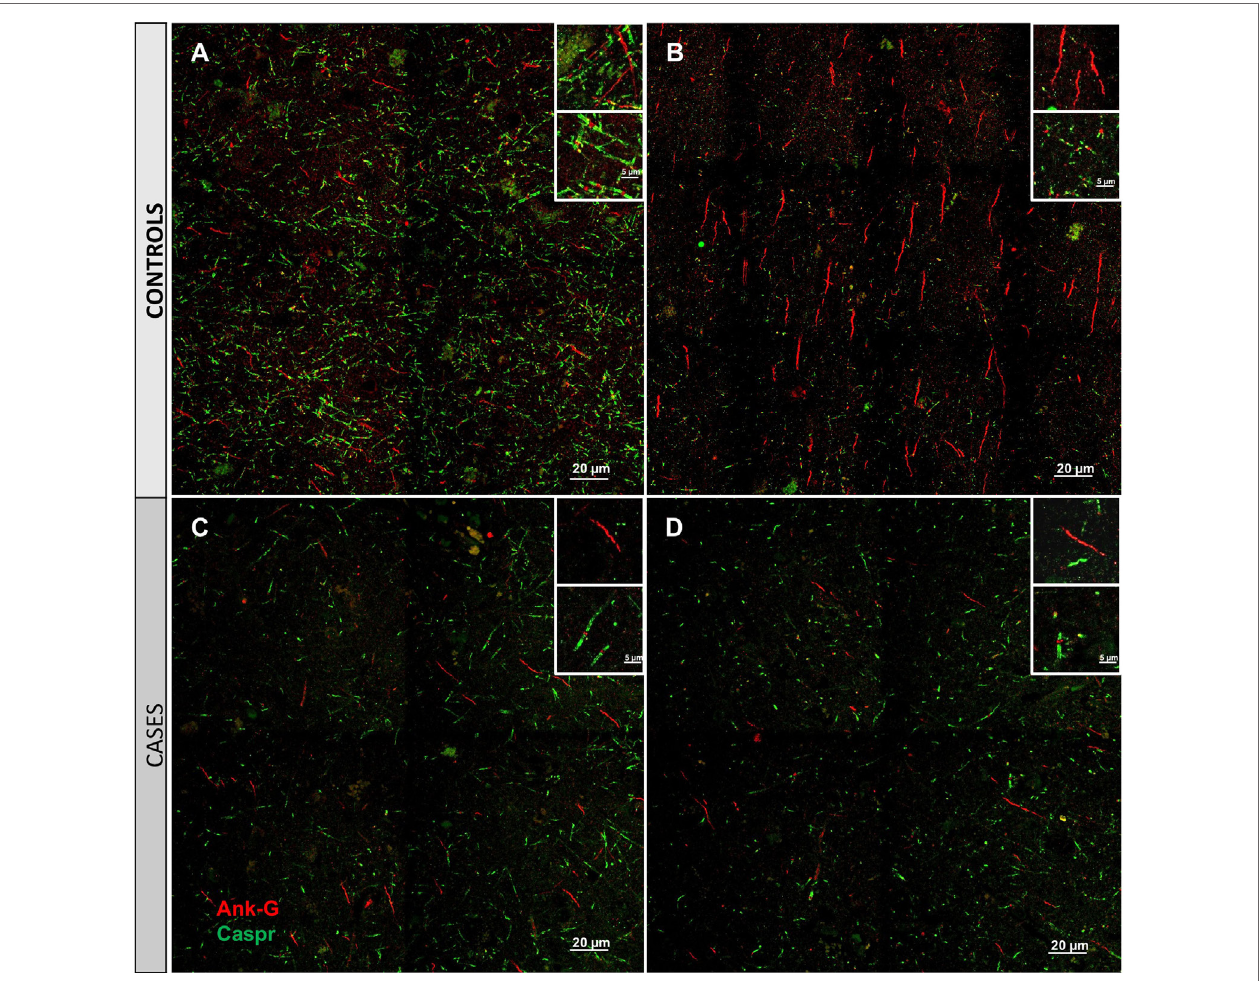
FigUre 2 | Immunofluorescent labeling for nodal and axon initial segment (AIS) marker ankyrin-G (Ank-G, red) and paranodal marker contactin-associated protein (caspr, green) in controls (a,b) and cases (c,D) . Labeling of AIS and nodal and paranodal axonal microdomains in cortical tissue from control cases reveals a regular pattern multiple intact node/paranode complexes (a) and multiple AISs (b) . In cortical tissue adjacent to a microinfarct from two different cases (c,D) , the frequency of intact AIS is dramatically reduced. Similarly, intact node/paranode complexes are rarely identified and when present often show paranodal elongation [inset (c) ]. Inset: magnification × 60, scale bar = 5